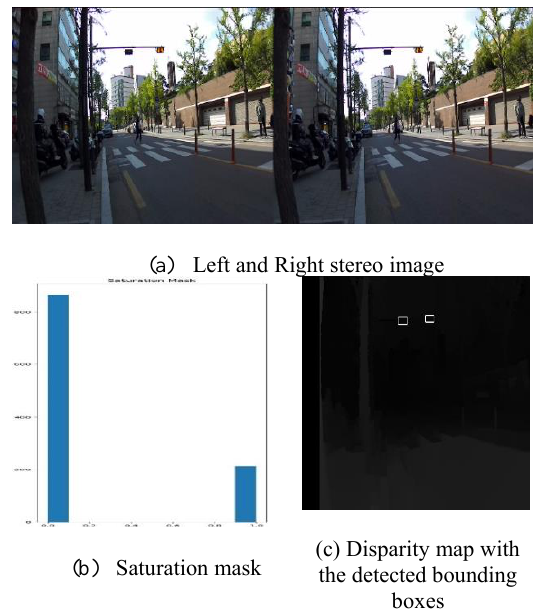
Fig. 2. Stereo images and their corresponding disparity map